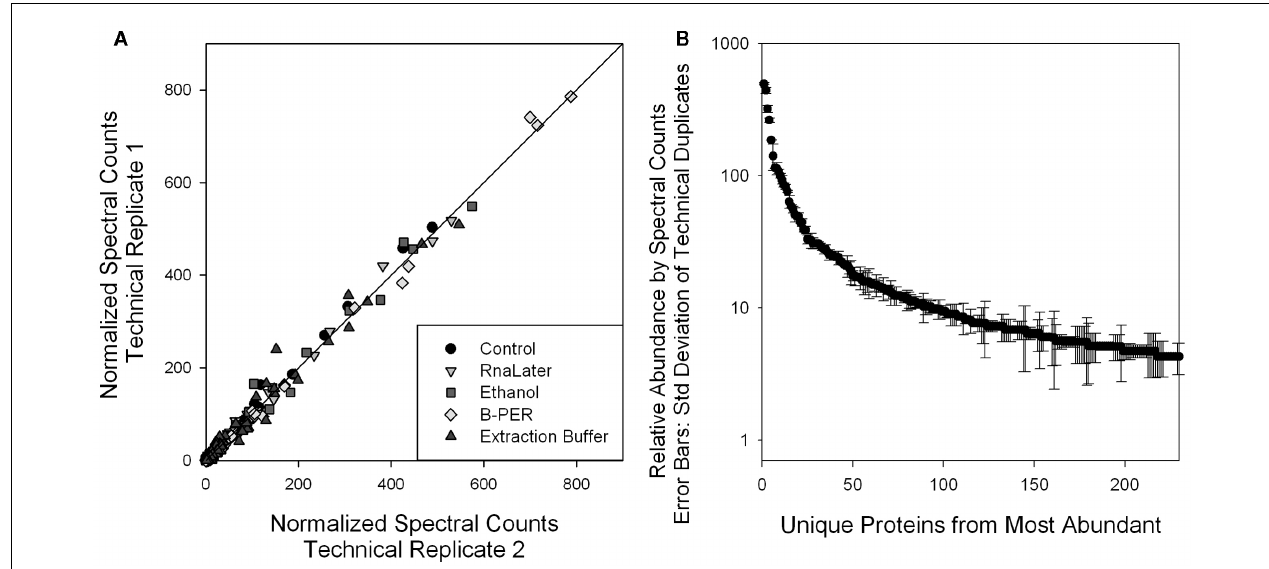
individual proteins with different preservation techniques used in Figure 5 . (B) Average and SD of the technical duplicate normalized spectral counts from the control sample. Relative SD is 26% or less for the 100 highest abundance proteins, as determined by spectral counts.This error is smaller than the several fold variation observed in degradation studies shown in Figure 5